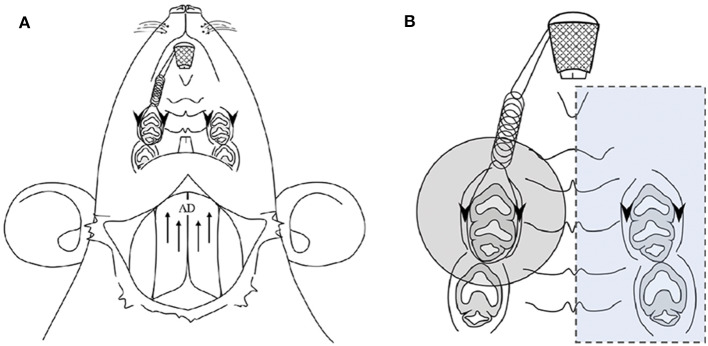
Application of experimental orthodontic force and recording of the jaw-opening reflex (A) and the oral region targeted for laser irradiation (B). (A) Schematic drawing of the application of experimental orthodontic force to the right maxillary first molar by the placement of a nickel-titanium closed-coil spring between the incisors. Electrodes were placed for recording the bilateral anterior digastric (AD) muscles by electromyography (EMG) as well as for electrical stimulation of the gingiva of the bilateral maxillary first molars. (B) The region targeted for laser irradiation is indicated by a shaded circle (ϕ14.6 mm, 1.67 cm2). The left molars and gingiva were covered with a silicone rubber impression material to avoid laser irradiation (blue square). Arrows: electrode insertion regions for EMG recording of AD muscles. Arrowheads: electrode insertion regions for electrical stimulation.